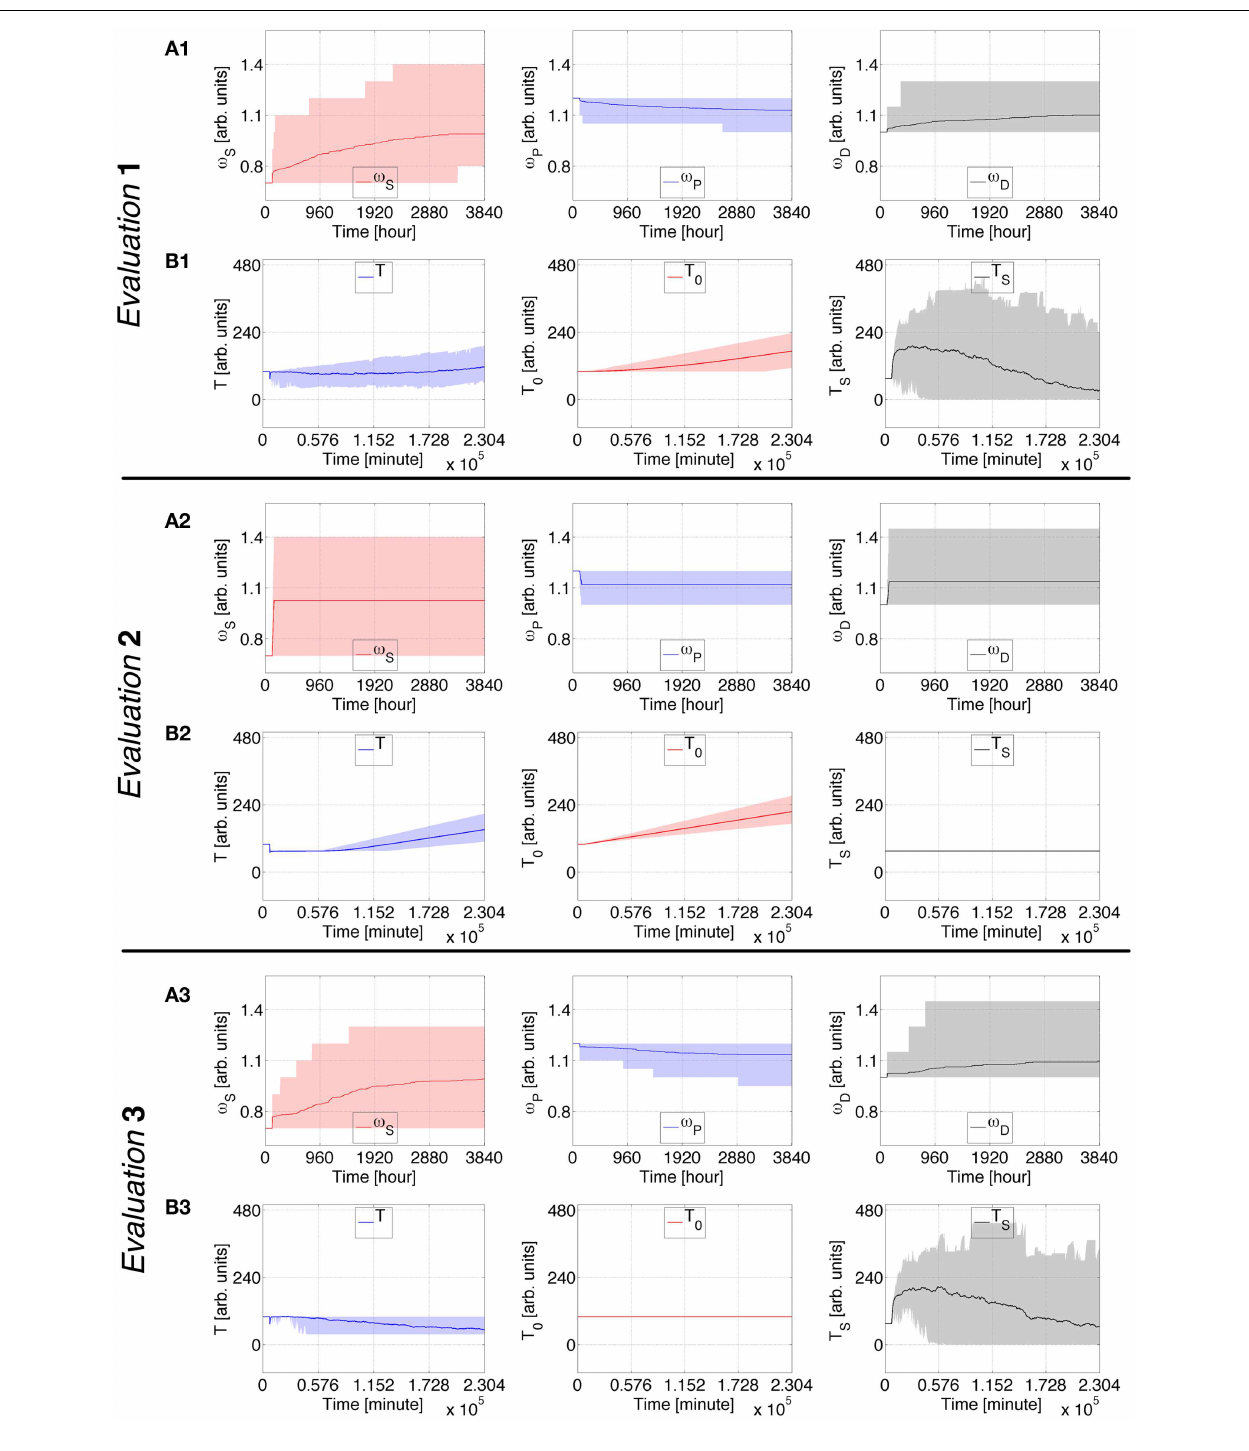
time-dependent and T 0 constant in Evaluation 3. (A1–A3 ) show the evolution of cognitive weights ω S , ω P , and ω D ; and (B1–B3) the progression of T , T 0 , and T S .The shades correspond to 95% simulation envelopes.The time-scales are hours for (A1–A3) , and minutes for (B1–B3) . Further details of these simulations are reported in FiguresS1 and S2 in Supplementary